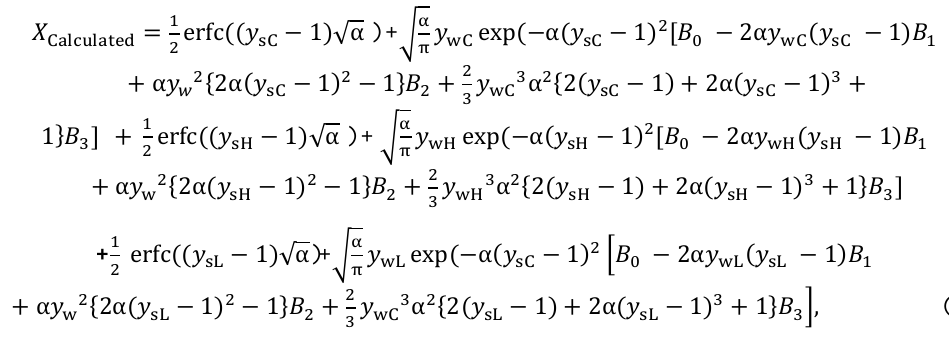
− 1) 2 [𝐵 − 2α𝑦 (𝑦 − 1)𝐵 sC 0 wC sC 1